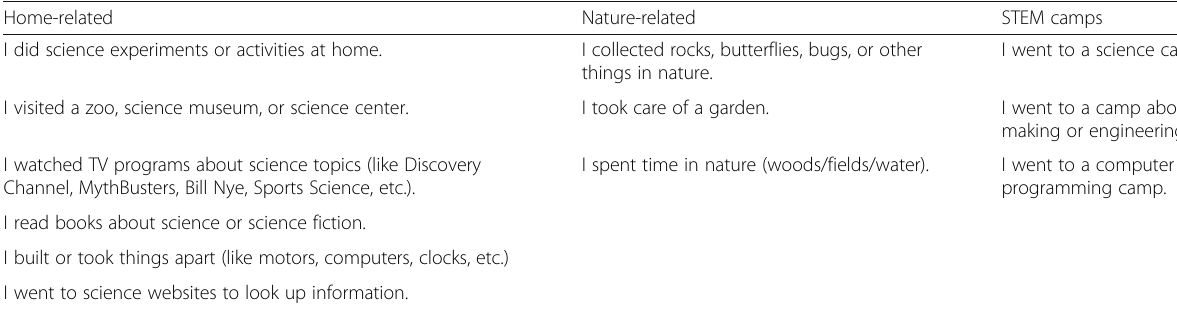
Table 1 Survey items within each type of optional summer science experience